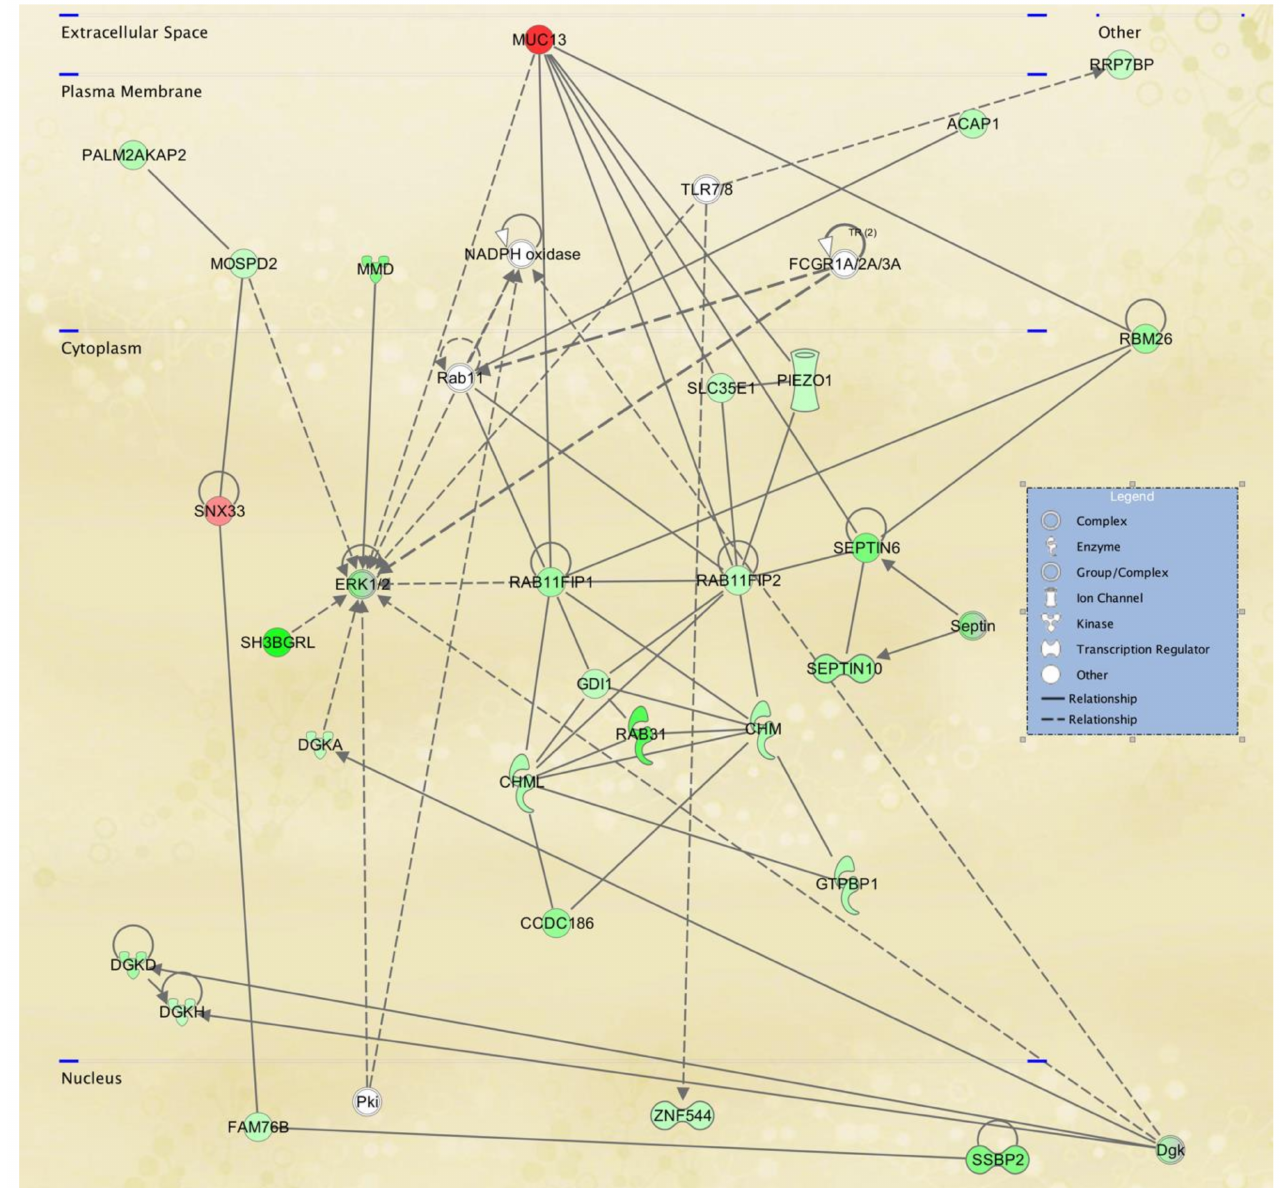
Figure 9. Hereditary disorder, organismal injury and abnormalities, post-translational modification network affected in lymphoblastoid cells derived from an SS patient. IPA network 17 includes two of the genes that were validated by qRT-PCR (MUC13 and